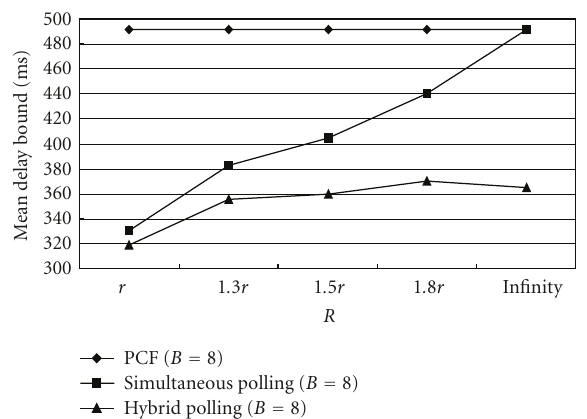
Figure 11: Mean delay bounds when the medium tra ffi c load ( B = 5) is imposed on IEEE 802.11a wireless LAN with 40 STAs.